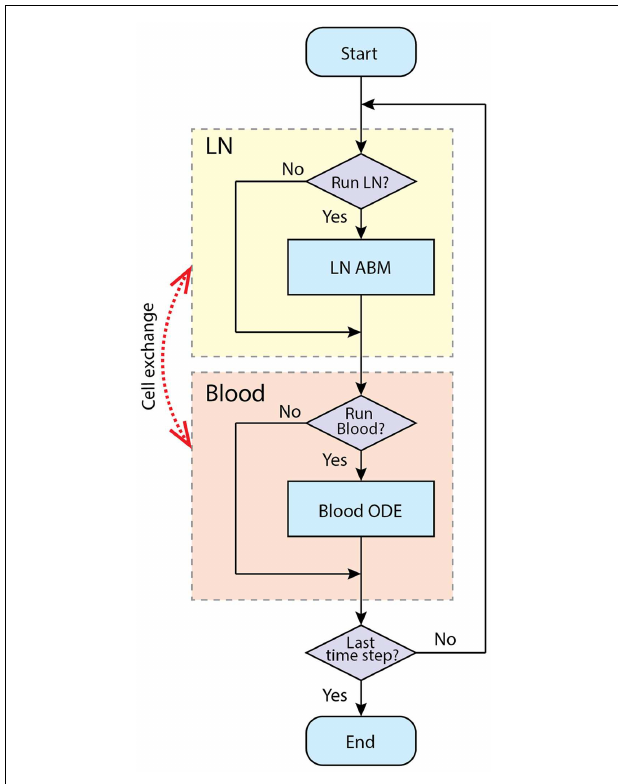
FIGURE 4 | Simulation procedure using tunable resolution . LN and blood compartment are processed sequentially in each time step. LNs recruit cells from blood and put exiting cells into it.The recruitment probabilities are modified by blood concentration of corresponding cell types. Each compartment has a switch to determine whether this compartment is processed in current time step, or will it be